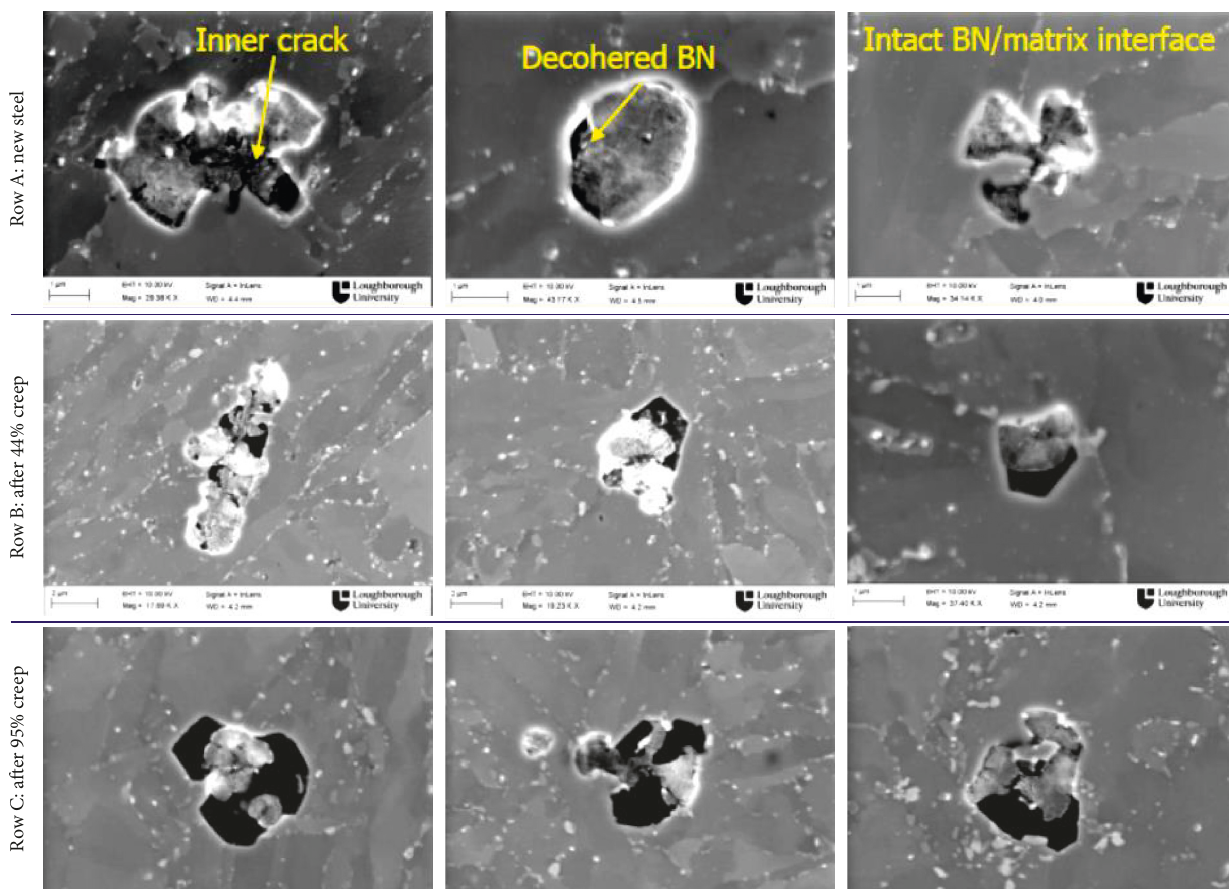
Figure 8: Micrographs from Grade 92 CSEF steel showing the development of creep cavities associated with BN particles, row A BN particles in new steel, row B after exposure to 44% creep life, and row C after exposure of 95% creep life.